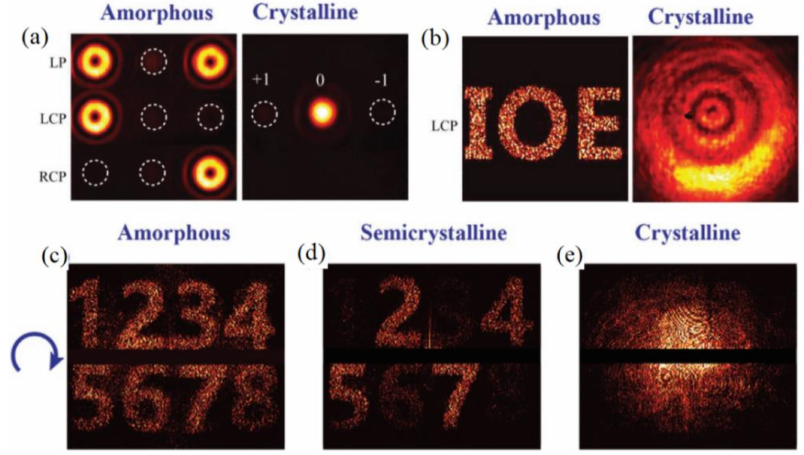
Figure 9. ( a ) Tunable helical phase and ( b ) holography for metadevices with switchable SOIs; the tunable holography achieved by the devices with multistate switching SOIs in the ( c ) amorphous, ( d ) semicrystalline and ( e ) crystalline states, respectively—all figures in ( a – e ) are reproduced with permissions from